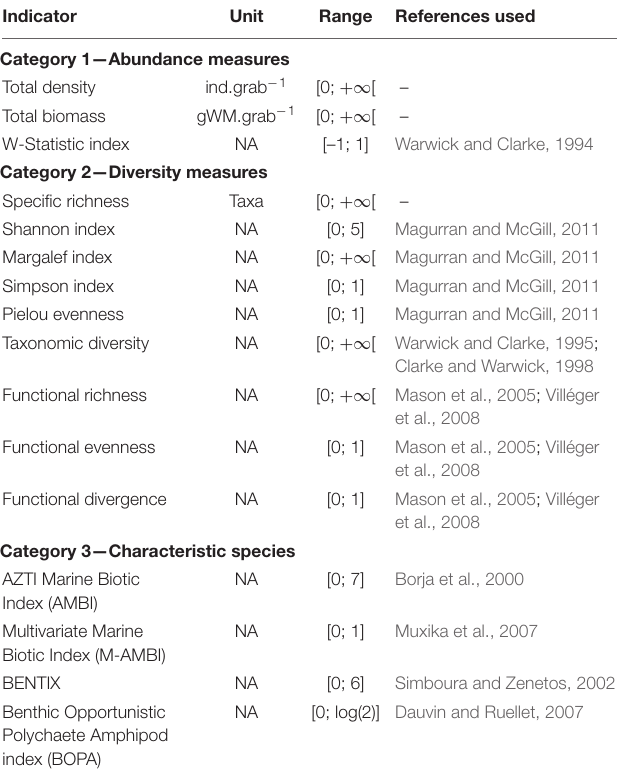
TABLE 1 | Summary of the evaluated indicators.